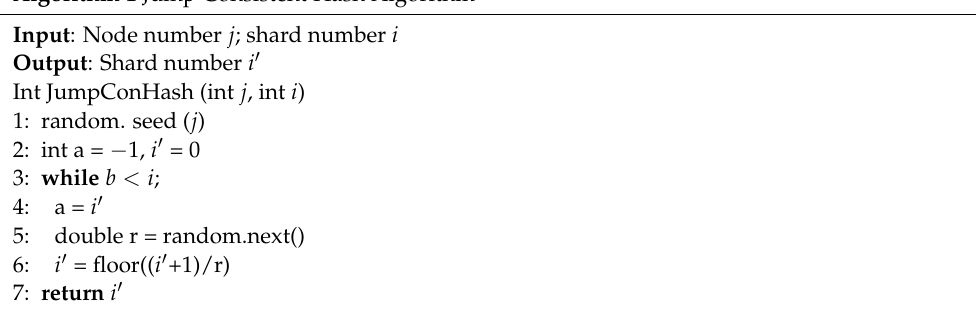
Algorithm 1 Jump Consistent Hash